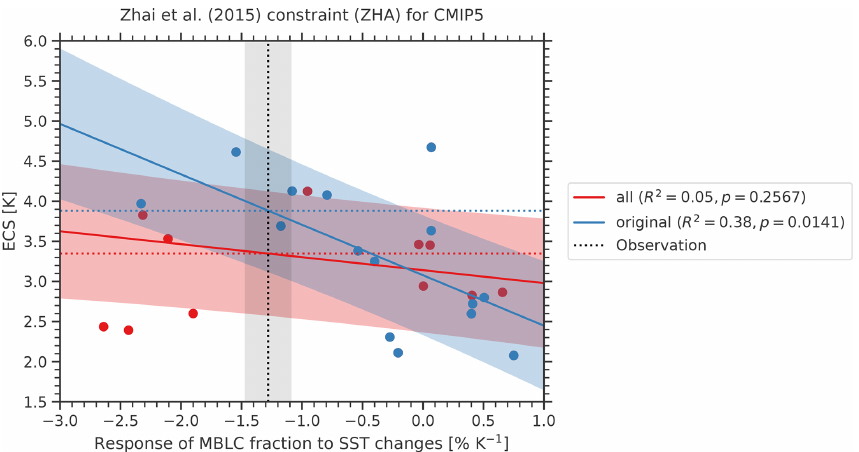
Figure 6. Emergent relationship ZHA (Zhai et al., 2015) for different subsets of CMIP5 models. Blue circles show the 15 CMIP5 models used in the original publication (except for CESM1-CAM5): the solid blue line and blue shaded area show the emergent relationships evaluated on these models including the uncertainty range. In our study, we added 11 more CMIP5 models (red circles). The corresponding emergent relationship that considers all available CMIP5 models is shown in red colors. This relationship shows a considerably lower coefficient of determination ( R 2 ) and higher p value than the relationship using the original subset of CMIP5 models. The vertical dashed line and shaded area correspond to the observational reference, and the horizontal dashed lines show the corresponding ECS constraints using this